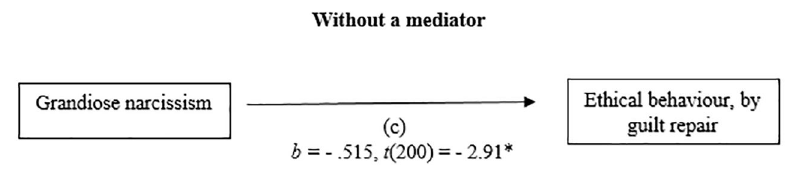
Figure 1. Mediation Analysis: Without a mediator.